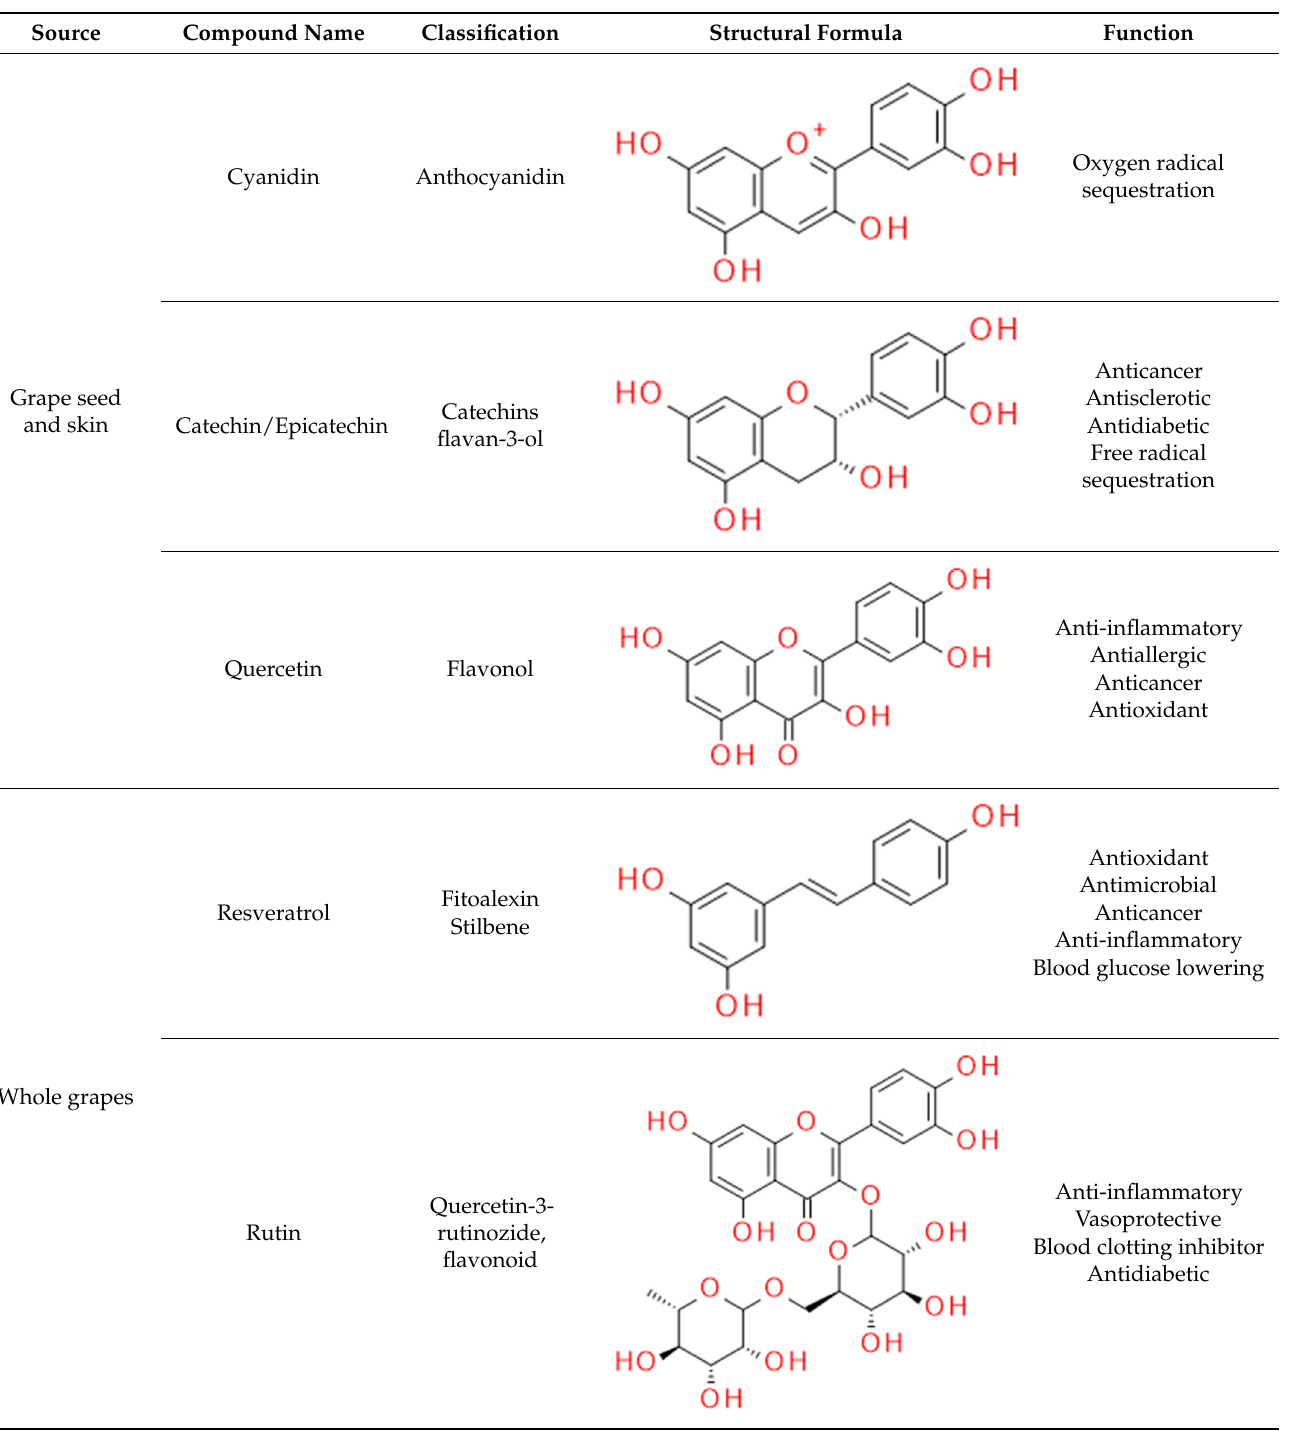
Table 2. Most important physiologically active compounds of the polyphenol fraction isolated from grape marc (grape seeds and grape